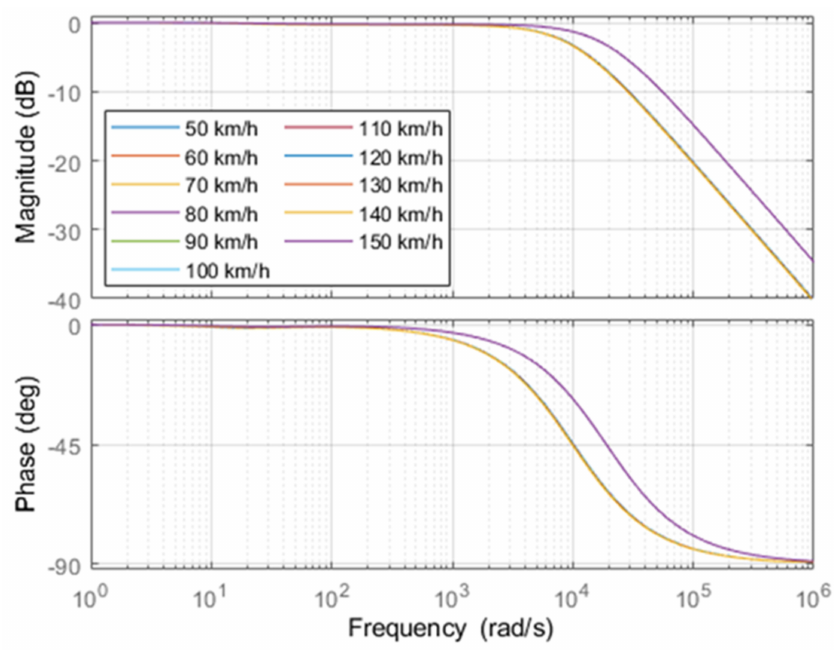
Figure 12. Bode diagrams for adaptive PID